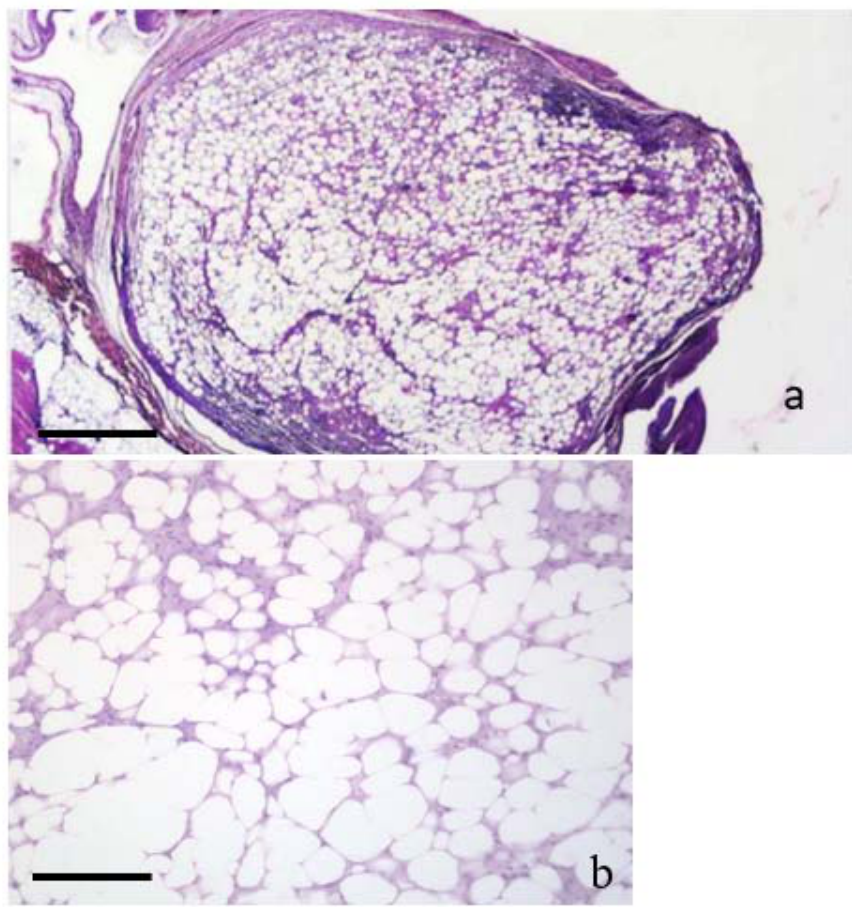
Figure 2. ( a , b ) LIPOMA. ( a , b ). Histological sections of a lipoma. ( a ) shows the lipoma arising from the dermis. The epidermal layer is mostly unaffected H&E (bar = 500 µ m). The capsule is the dermis. The epidermal layer is mostly unaffected H&E (bar = 500 μ m). The capsule is present, and infiltration of lymphocytes can be seen in the subcapsular area. ( b ) Higher magnification of ( a ). The nodule is composed of adipocytes, generally well separated from each other by a thin cytoplasm layer. The large central vacuole displaces the nuclei to the cellular periphery. Cells are almost uniform in size and shape. H&E (bar = 100 μ m).